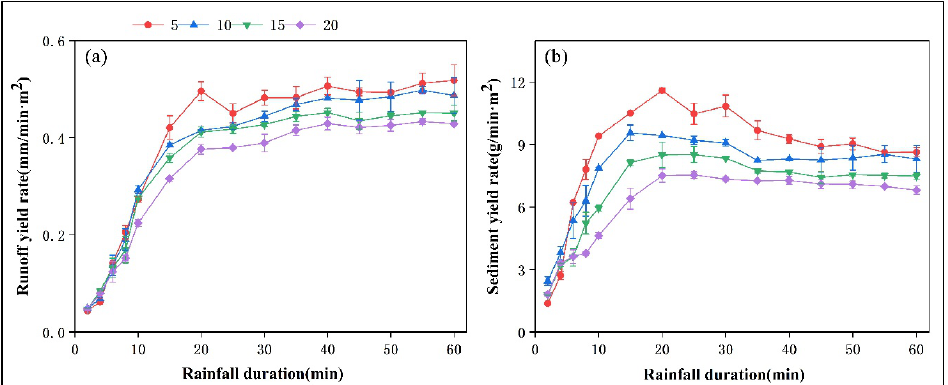
Figure 5. Variation in runoff rates ( a ) and sediment transportation ( b ) under different numbers of vegetation patches.